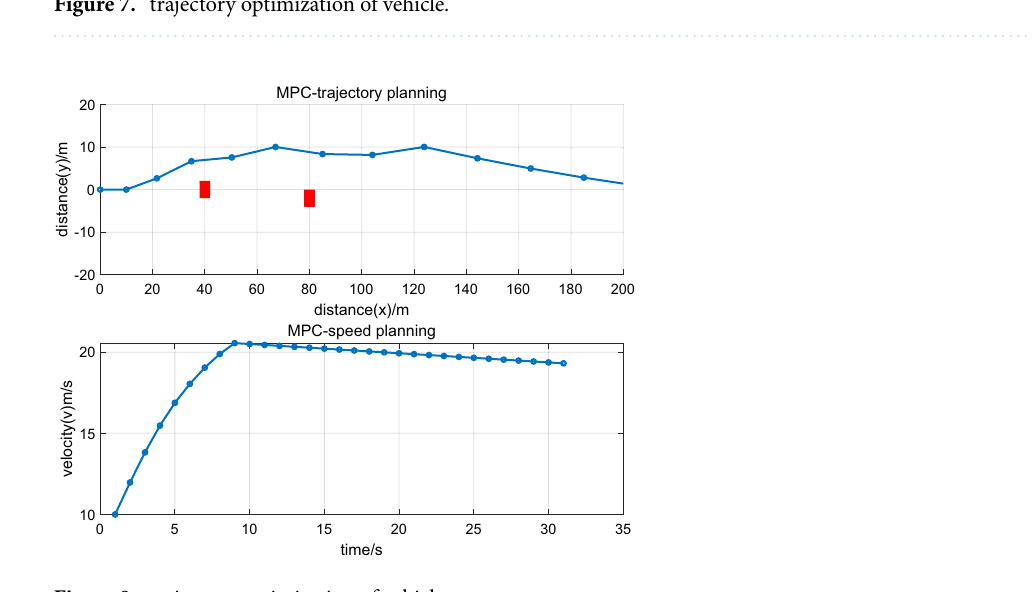
Figure 7. trajectory optimization of vehicle.